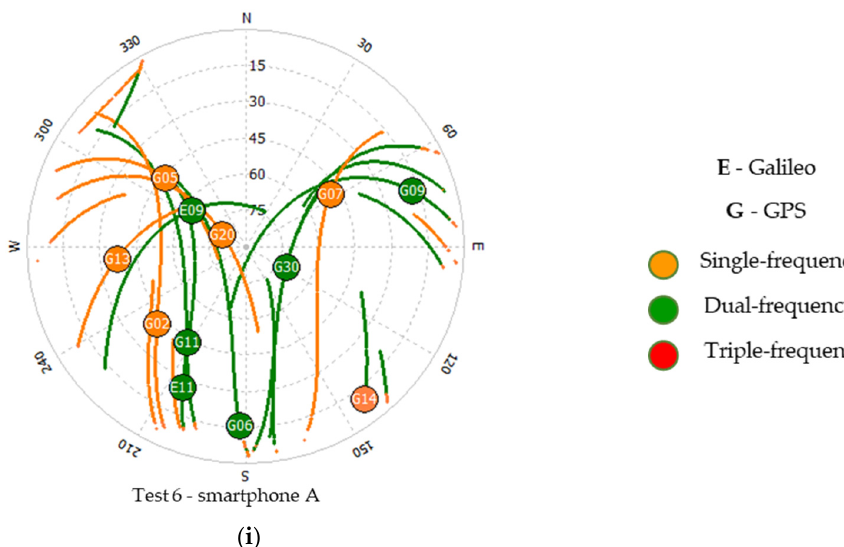
Figure 4. Skyplot: Test 1 smartphone A ( a ) and smartphone B ( b ); Test 2 smartphone ( c ) and Alloy receiver ( d ); Test 3 smartphone ( e ) and PolaRx5 receiver ( f ); Test 4 smartphone ( g ), Test 5 smartphone ( h ); Test 6 smartphone ( i ).